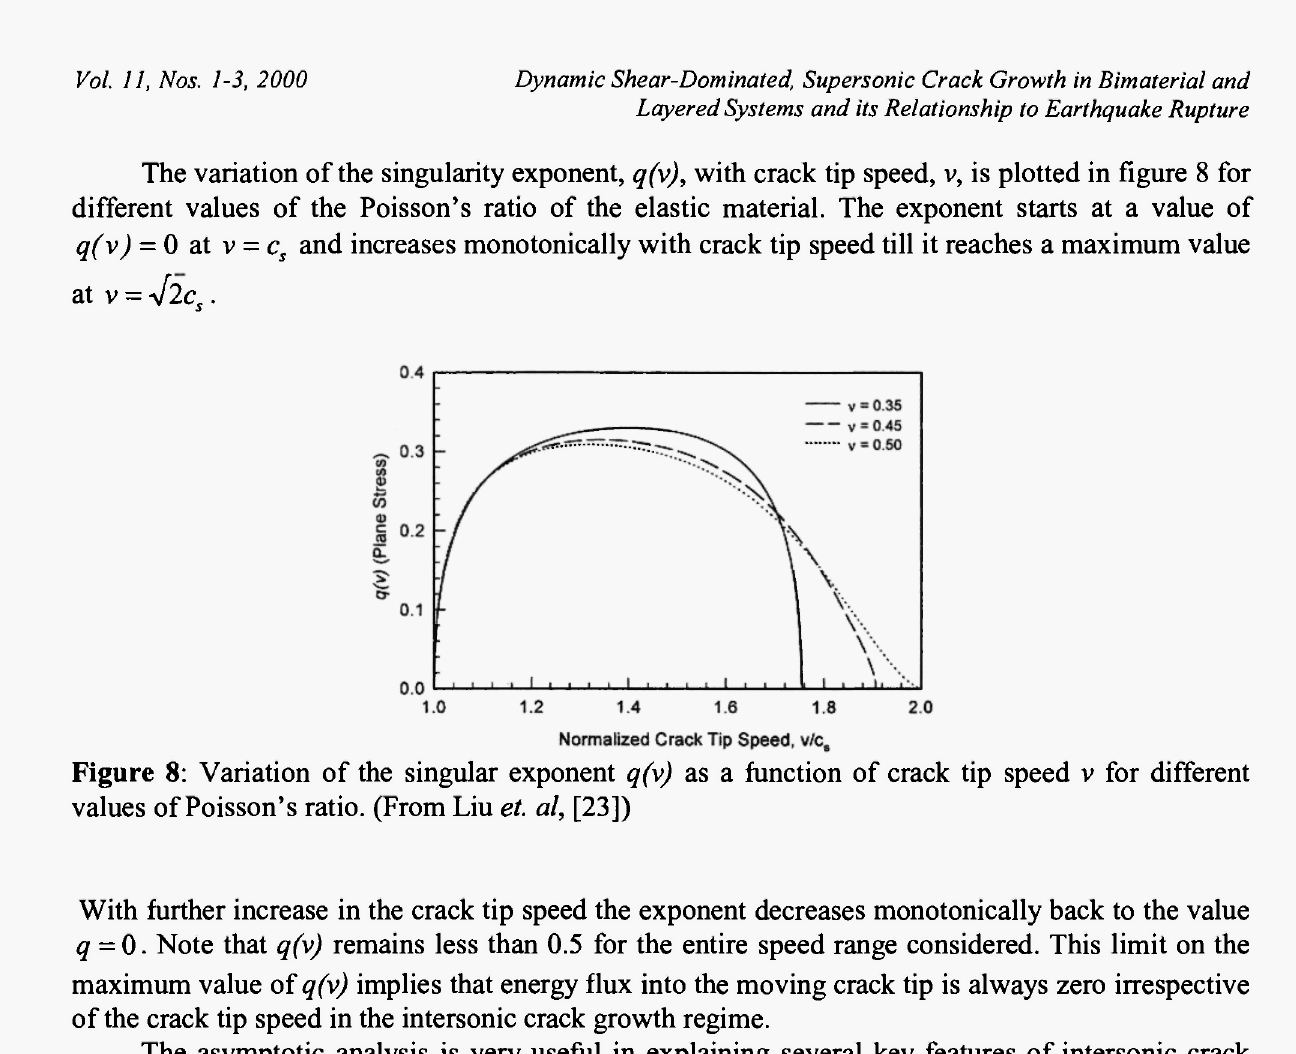
Figure 8: Variation of the singular exponent q(v) as a function of crack tip speed ν for different values of Poisson's ratio. (From Liu et. al,